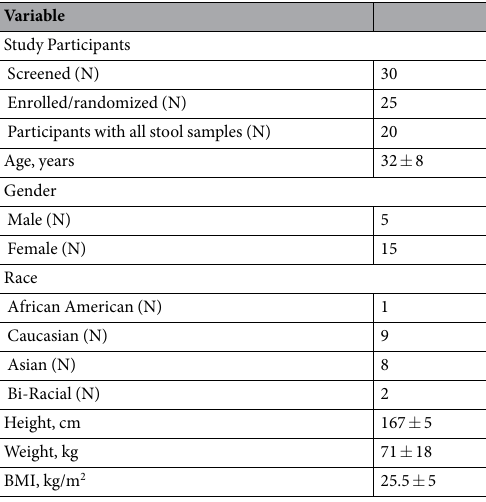
Table 1. Baseline characteristics of the study